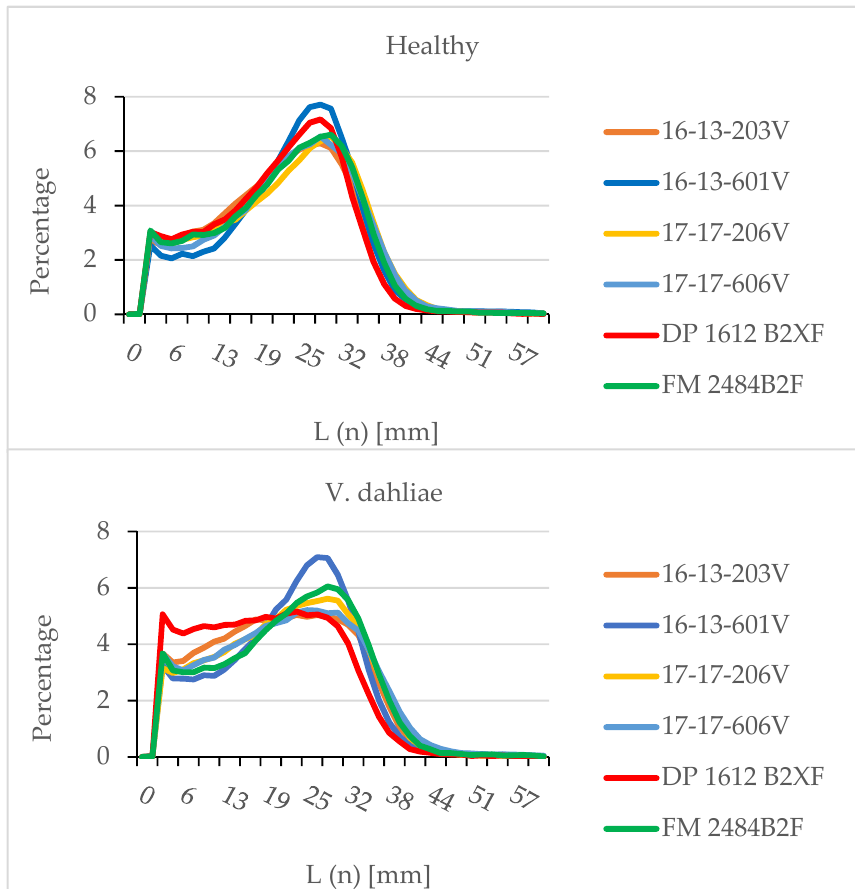
Figure 4. Fiber length distribution of greenhouse-grown upland cotton: healthy ( top ) and inoculated with Verticillium dahliae ( bottom ). L (n) [mm], length by number in millimeters.